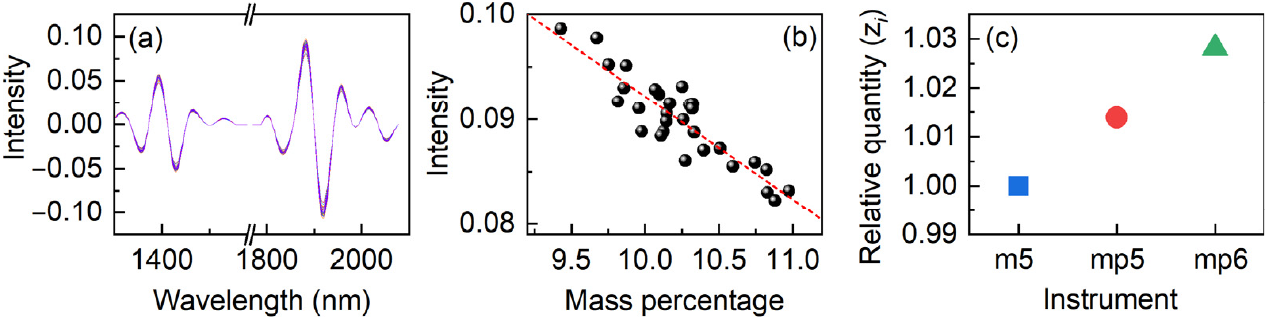
Figure 2. Standardized signal ( SS ) ( a ), the relationship between the intensity at 1882 nm and the mass percentage of moisture ( b ), and the relationship between the relative quantity ( z i ) and instruments ( c ). The linear regression appears as the red dash.